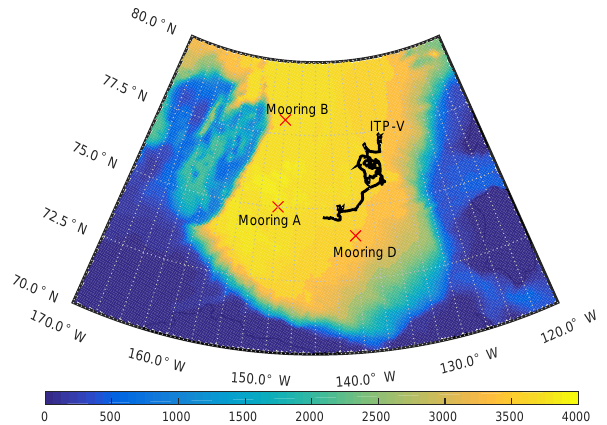
Figure 2. Bathymetry and location of ITP-V and mooring for data